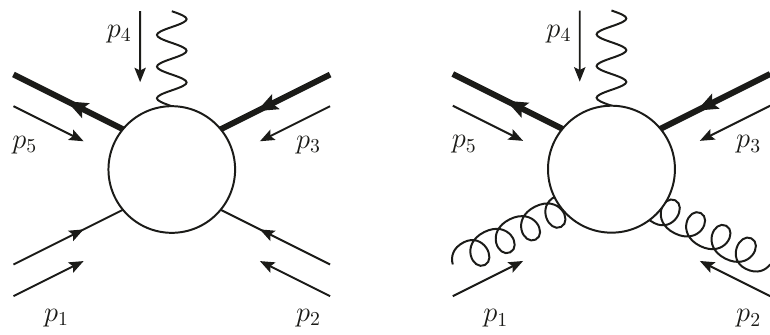
Figure 2 . The kinematics of quark and gluon initiated processes. Massive quark lines are indicated in